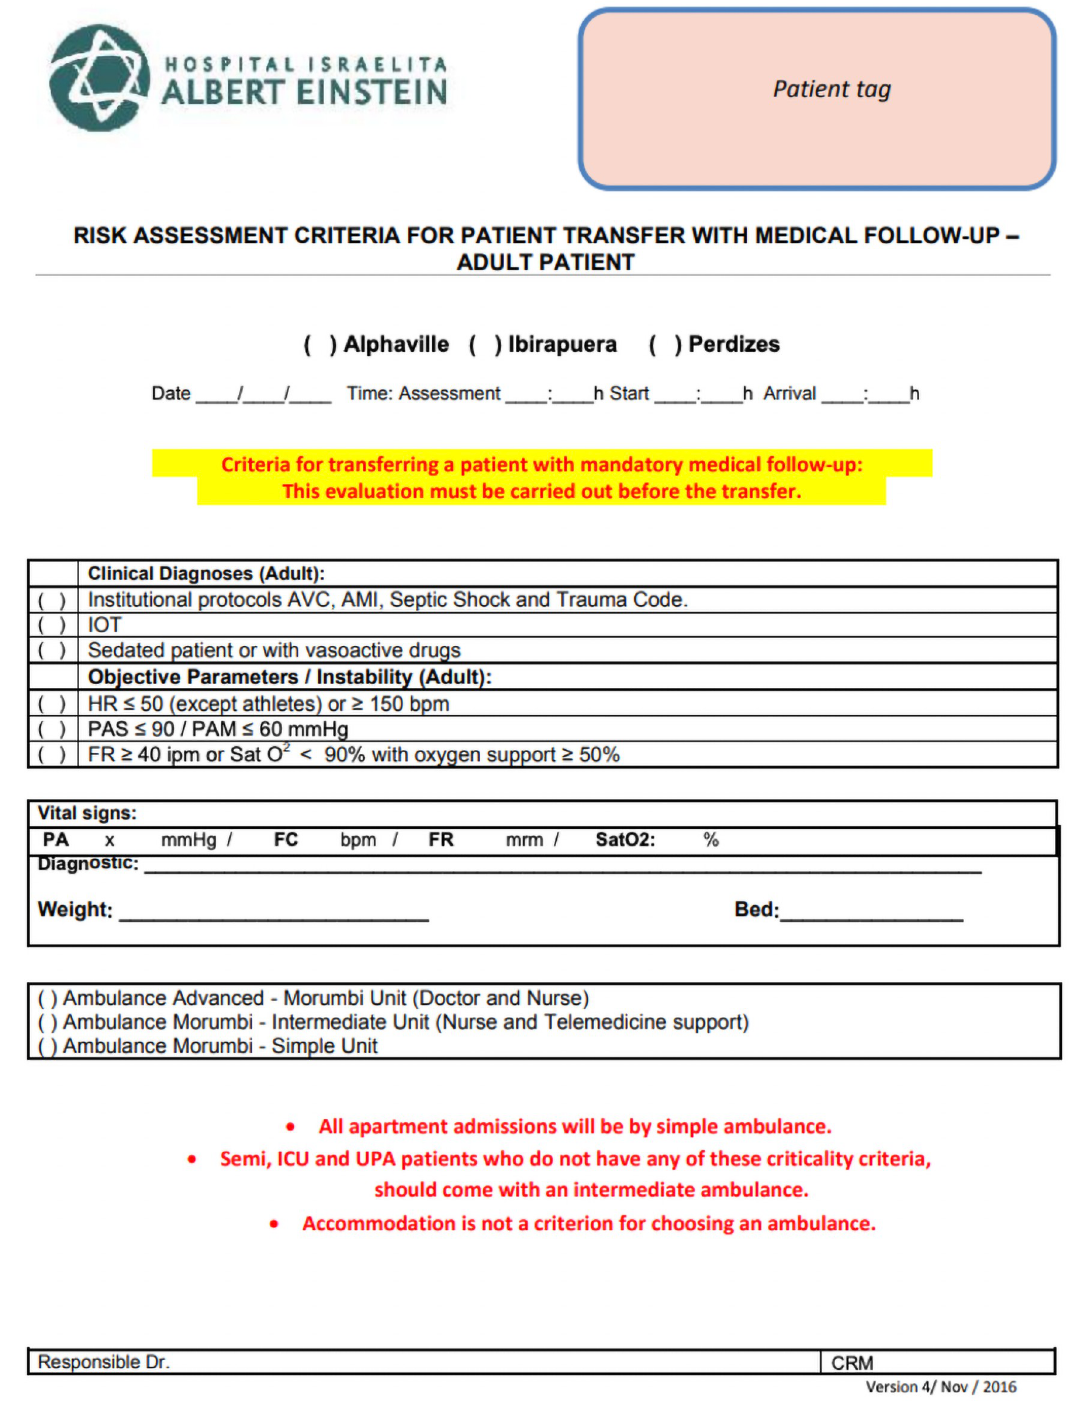
Fig 3. Checklist completed before